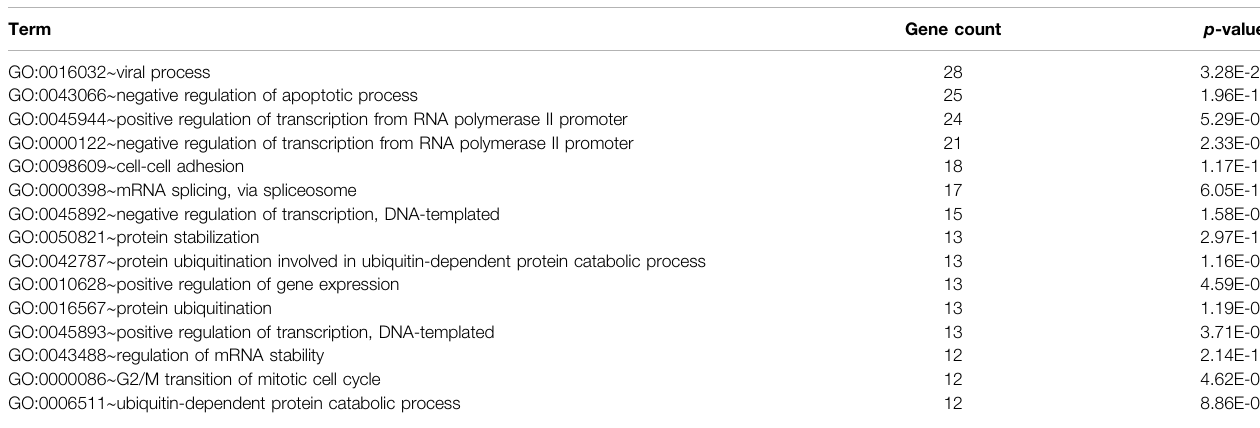
TABLE 2 | GO enrichment analysis of potential core targets for DSD against